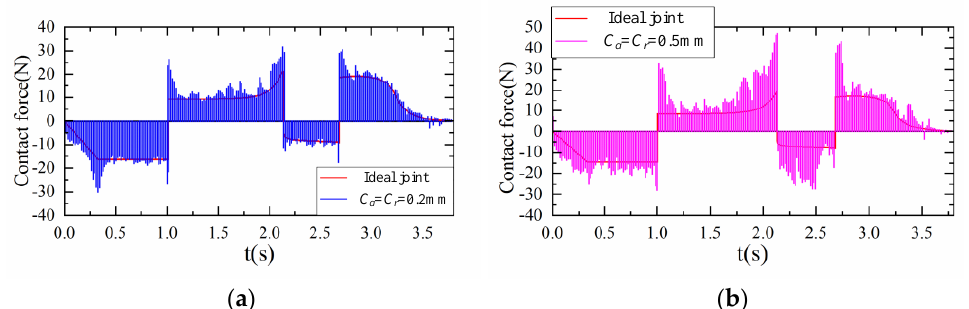
Figure 15. Contact force of joint B in the Z direction. ( a ) The contact force in the Z direction when both clearances are 0.2 mm and ( b ) the contact force in the Z direction when both clearances are 0.5 mm.